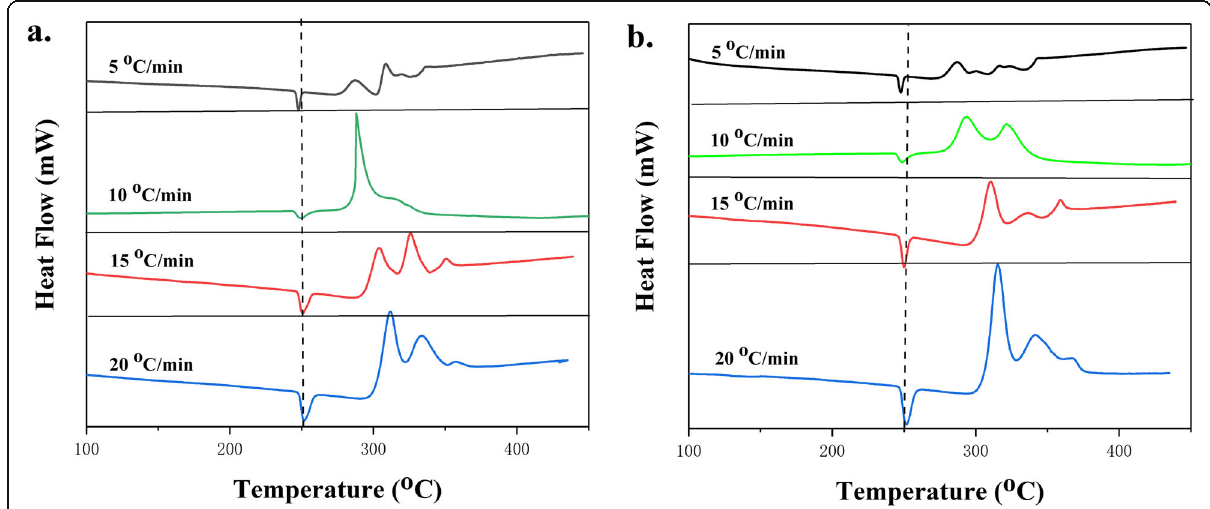
Fig. 8. The effect of heating rate on DSC results of a AP/MOF-5 and b AP/GO@MOF-5 (N 2